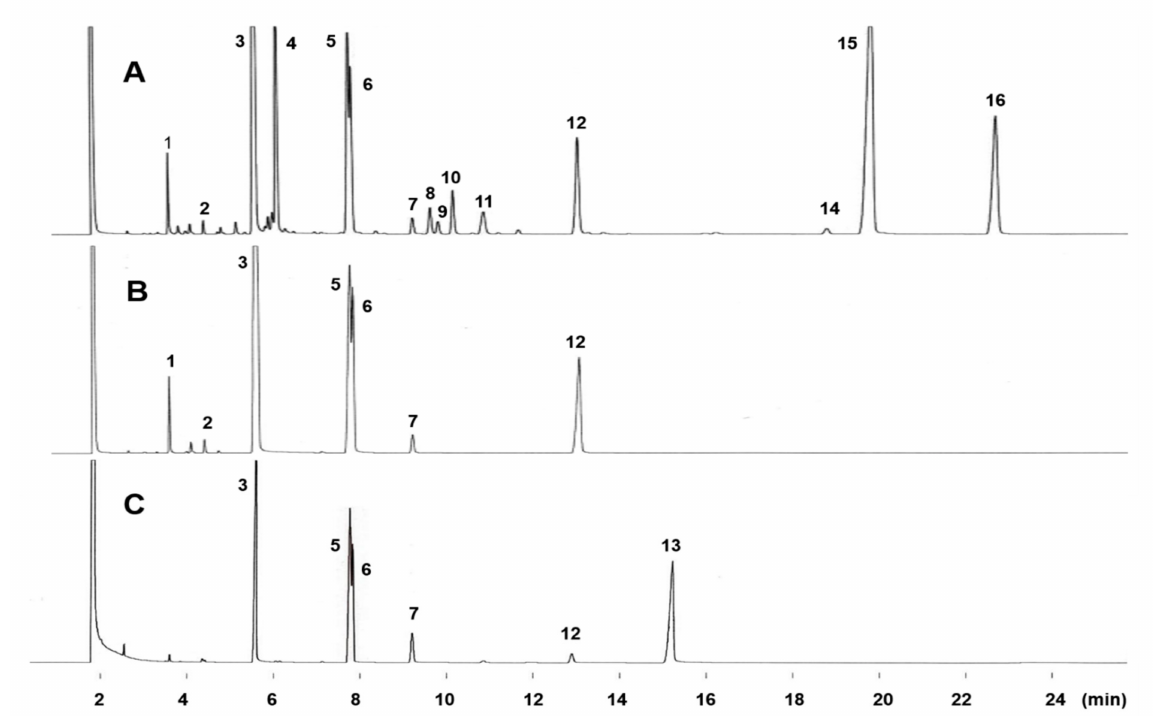
Figure 1. GC profiles of total fatty acid methyl esters from Solieria pacifica ( A ), their saturated fraction obtained by Ag + -TLC ( B ), and the hydrogenated FAME of total fatty acids ( C ) on Omegawax 320. The column temperature was programmed from 160 ◦ C to 230 ◦ C at 1 ◦ C /min. Other GC conditions are given in text. Peak identification: 1 = 14:0; 2 = 15:0; 3 = 16:0; 4 = 16:1n-5; 5 = cis -11,12-methylene-hexadecanoic acid; 6 = 11-cyclopentylundecanoic acid; 7 = 18:0; 8 = 18:1n-9; 9 = 18:1n-7; 10 = 18:1n-5; 11 = 18:2n-6; 12 = 13-cyclopentyltridecanoic acid; 13 = 20:0; 14 = 20:3n-6; 15 = 20:4n-6; 16 =